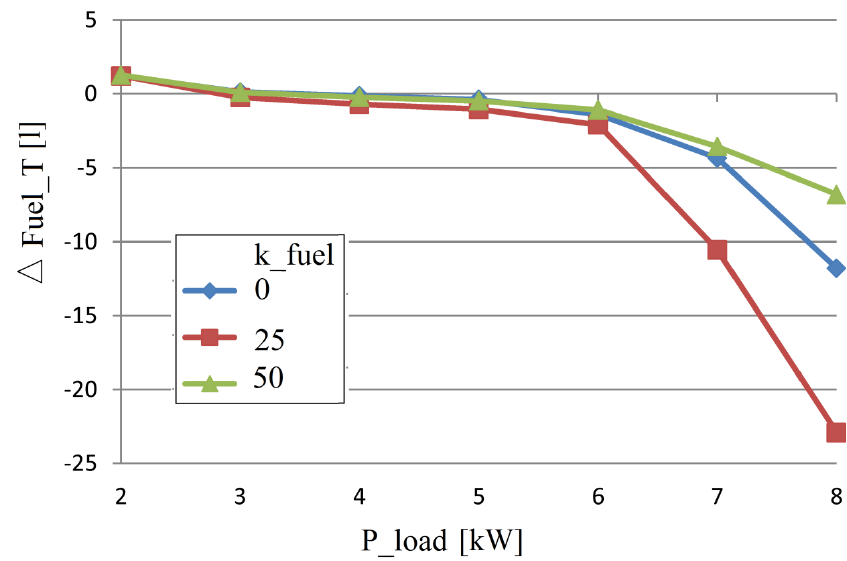
Figure 7. The values of the fuel economy, in the all situation, for the RTO1 strategy: A ( k fuel = 0), B ( k fuel = 25), and C ( k fuel = 50) under constant load.